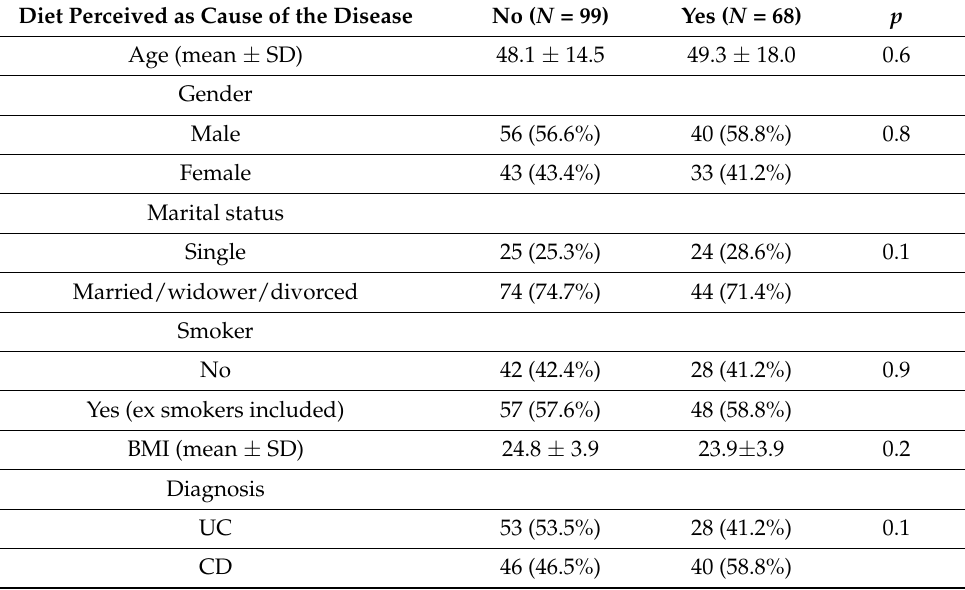
Table 3. Comparison between patients who perceived and patients who did not perceive diet as the cause of their